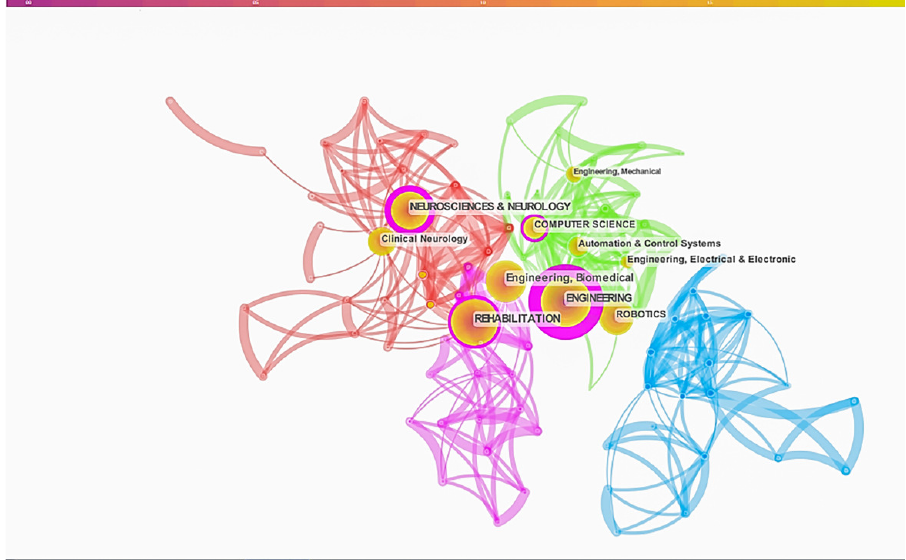
Figure 2. Subject category co-occurrence.